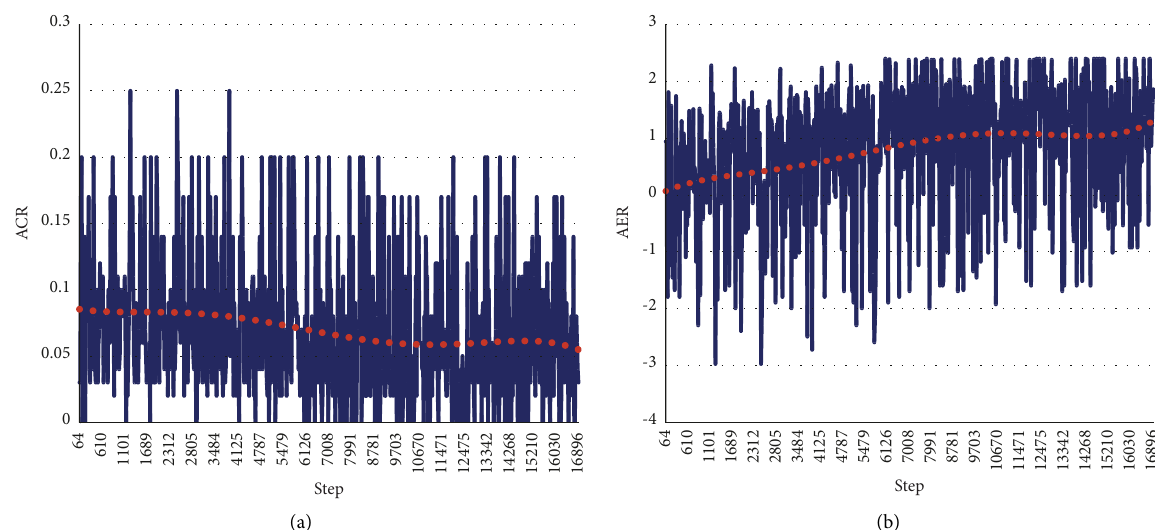
Figure 5: ACR and AER with respect to training steps.(a) ACR. (b) AER.